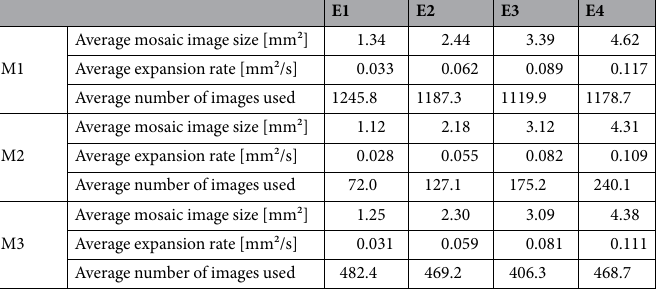
Table 2. Mosaic image sizes and area expansion rates for examinations E1 through